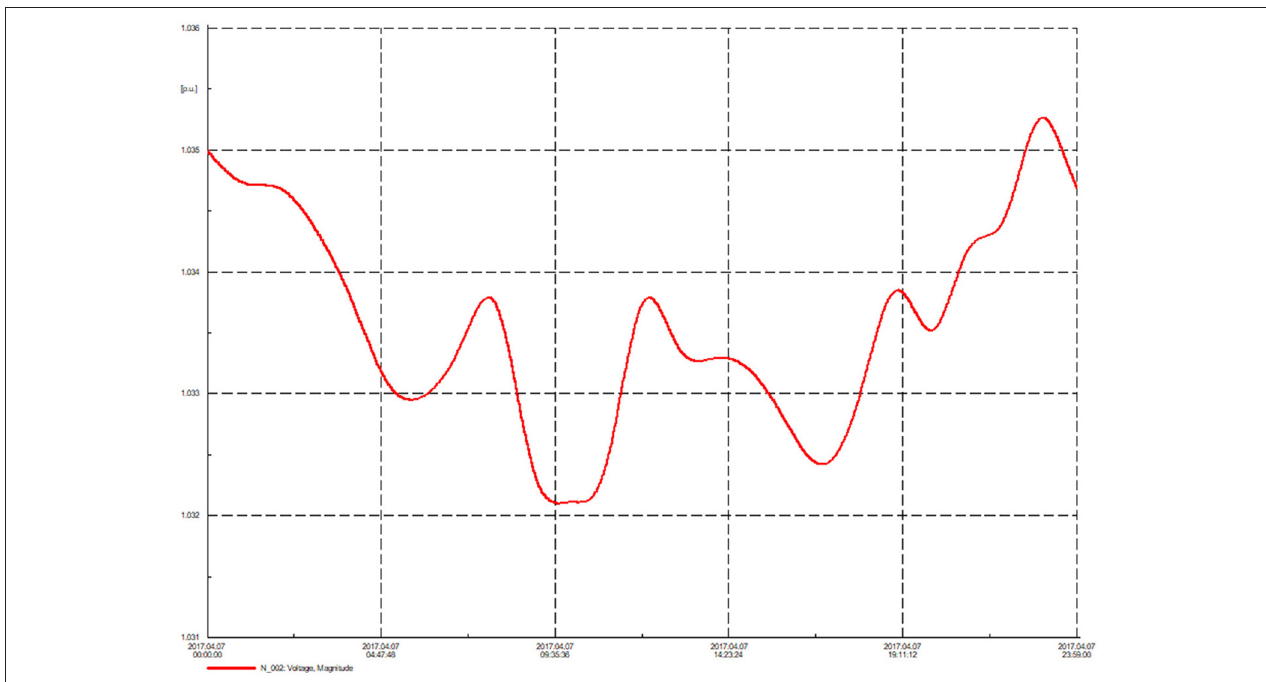
FIGURE 9 | Test case 1—with DIgSILENT.